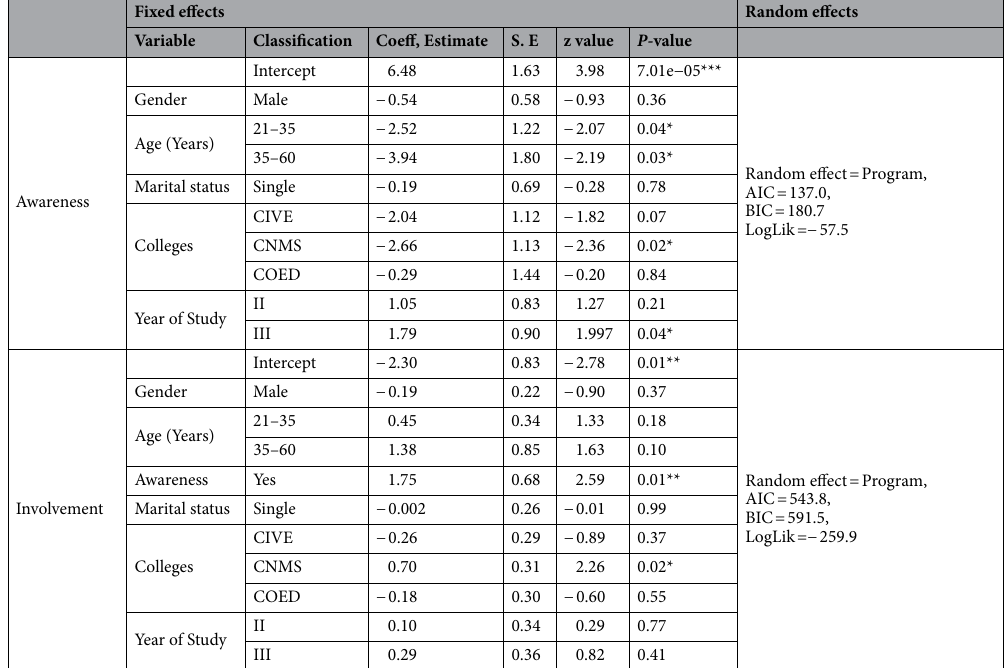
Table 4. The association of awareness and the involvement of respondents with their gender, age, marital status, colleges their belong and years of study. P-value , probability value; S. E. , standard error; CNMS , college of natural and mathematical science; CHSS , college of humanities and social science; CIVE college of informatics and virtual education; COED , college of education. Significant effects were considered when P < 0.05, *-Significant effects seen.